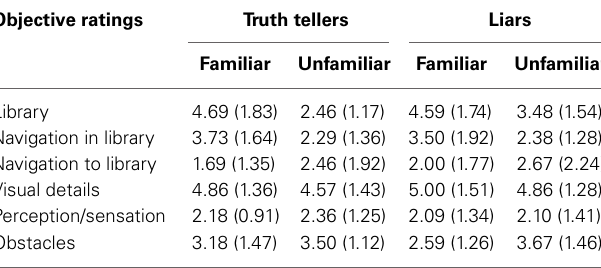
Table 2 | Means (and standard deviations) of the type of details for Veracity and